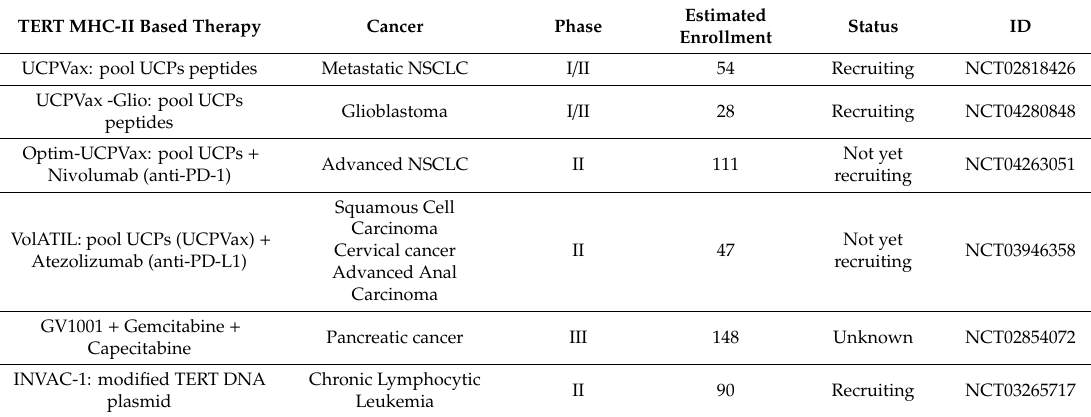
Table 3. Ongoing clinical trials based on the stimulation of TERT-specific CD4 Th1